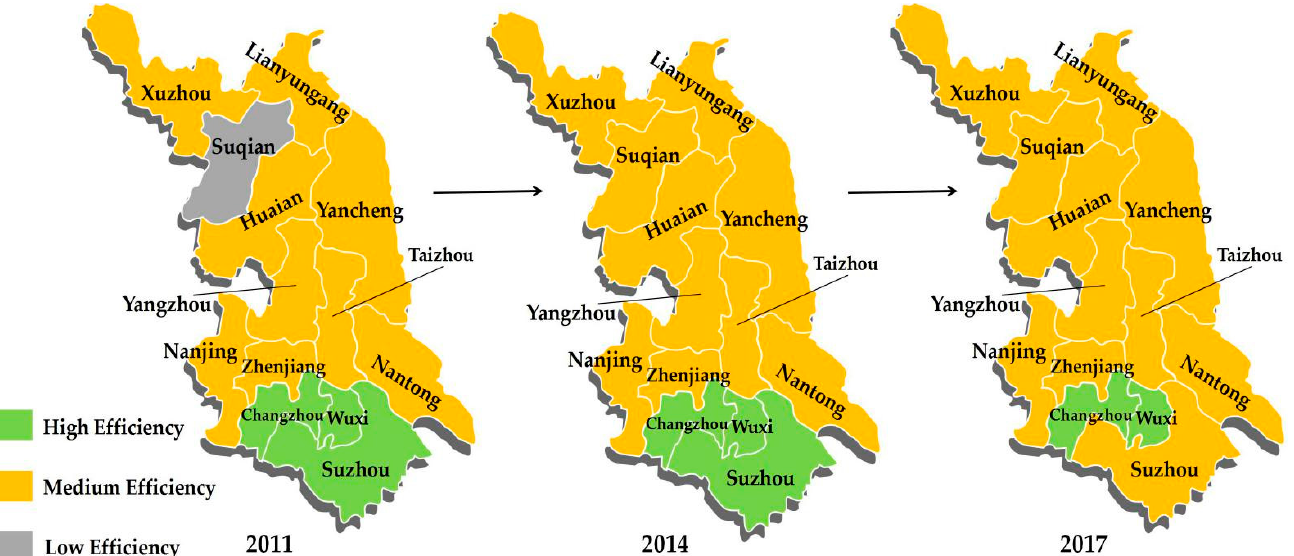
Figure 9. Spatio-temporal evolution map of land economic efficiency in Jiangsu Province.